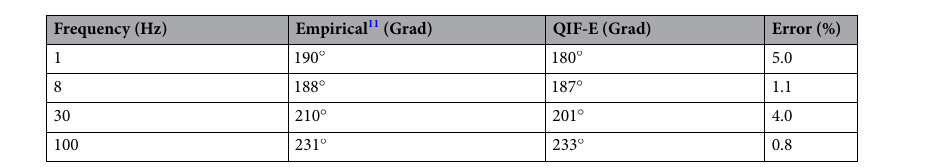
Table 2. Results of subthreshold empirical phase differences, and phase differences obtained by the QIF-E model. The last column contains the relative errors. Model data configuration of 100 nA, 20 dB and τ .